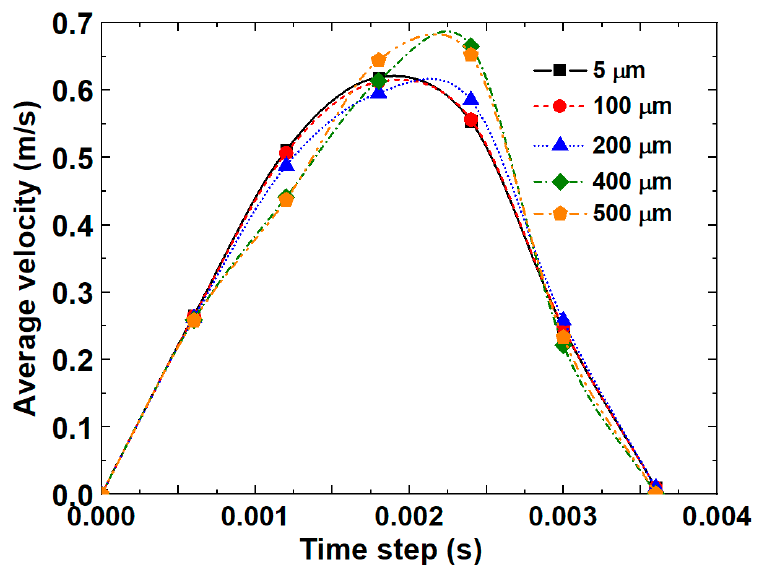
Figure 6. Plot of average velocities during the upsetting process.